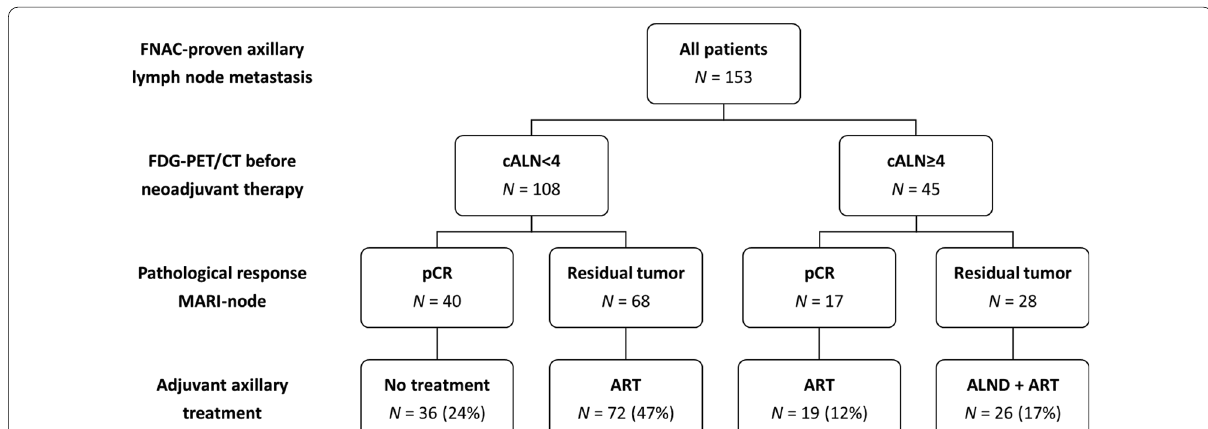
Fig. 2 Tailored axillary treatment according to the MARI‑protocol. Protocol deviations occurred in 10 patients: six cALN<4 patients with pCR of the MARI‑node received ART, two cALN<4 patients without MARI‑node pCR received no further treatment and two cALN MARI‑node pCR did not undergo ALND. FNAC fine‑needle aspiration cytology, cALN < 4 less than four FDG‑positive axillary lymph nodes, cALN